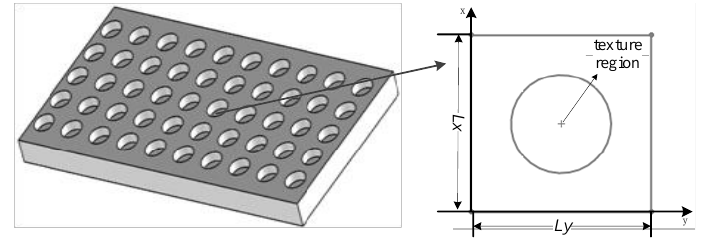
Figure 3. Geometric model of texture control unit.